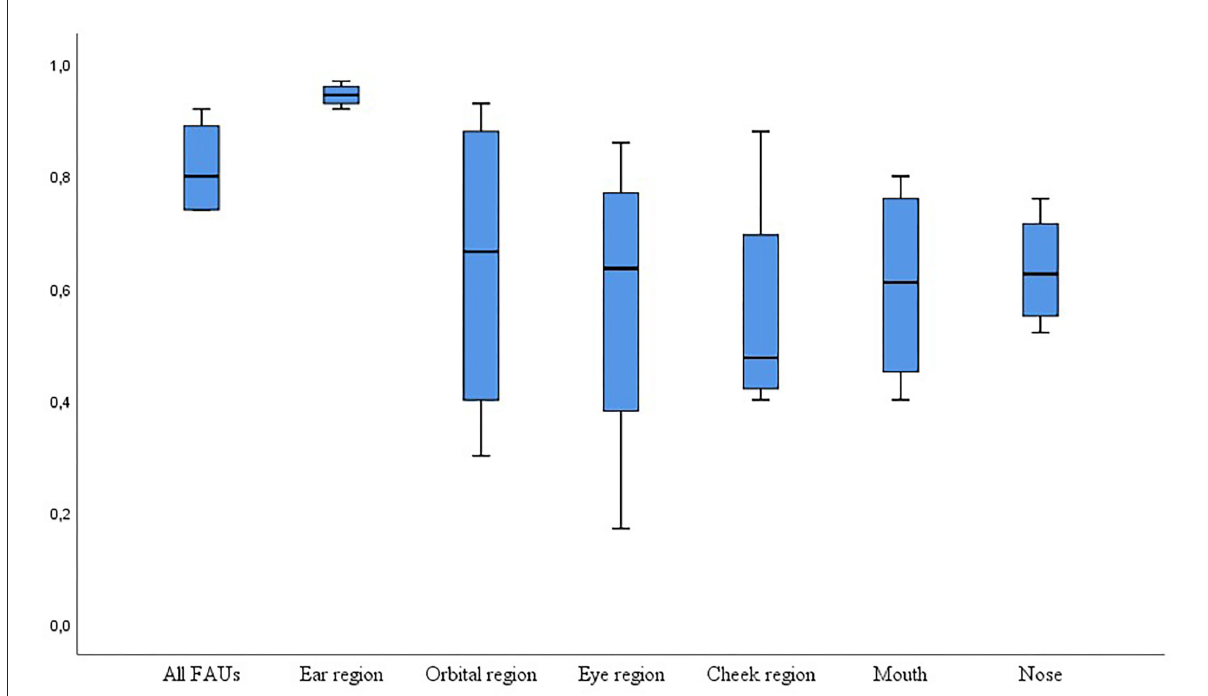
FIGURE2 Box-plot graph for interclass coefficient (ICC) for interobserver reliability tested with Cohen’s kappa coefficient ( y -axis) for all facial action units scored ( n = 19 studies) and for scores based on a single facial action unit ( n = 11 studies). Agreement was “very good” with an ICC of 0.81–1.0, “good” with an ICC of 0.61–0.80, and moderate with an ICC of 0.41–0.6